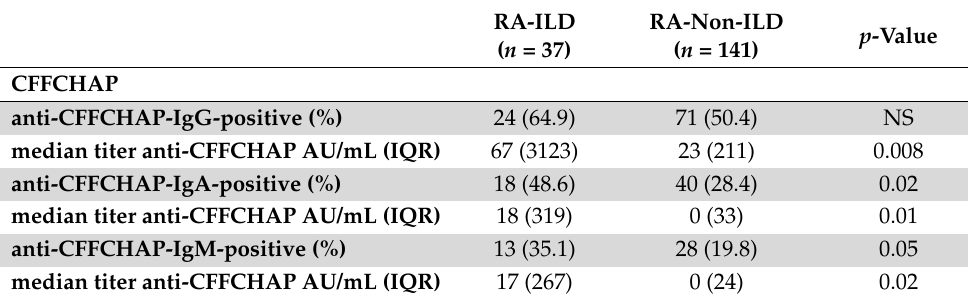
Table 3. Autoantibody status in RA patients (ILD vs. non-ILD).